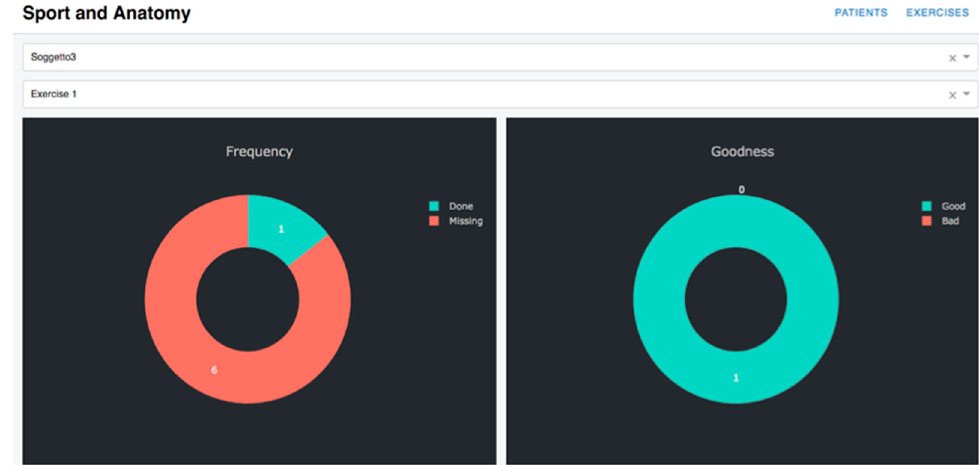
Figure 9. Professional interface, patient overview.